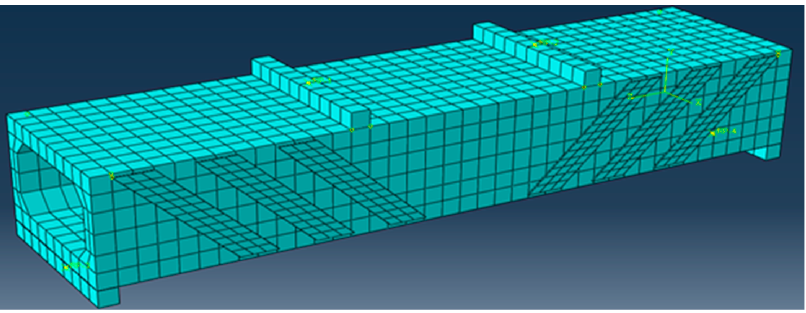
Figure 18. Finite element model of the prestressed hollow slab reinforced component.